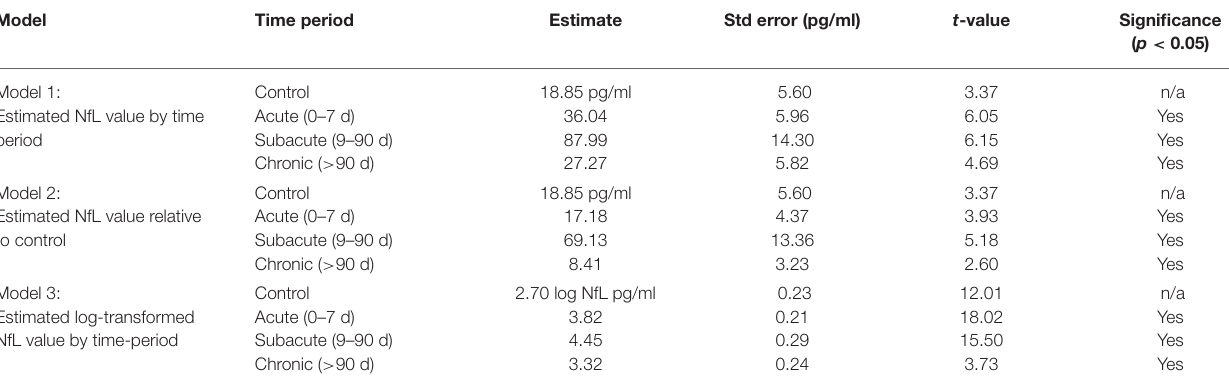
TABLE 3 | Random effects mixed models for blood NfL values during stroke epochs.